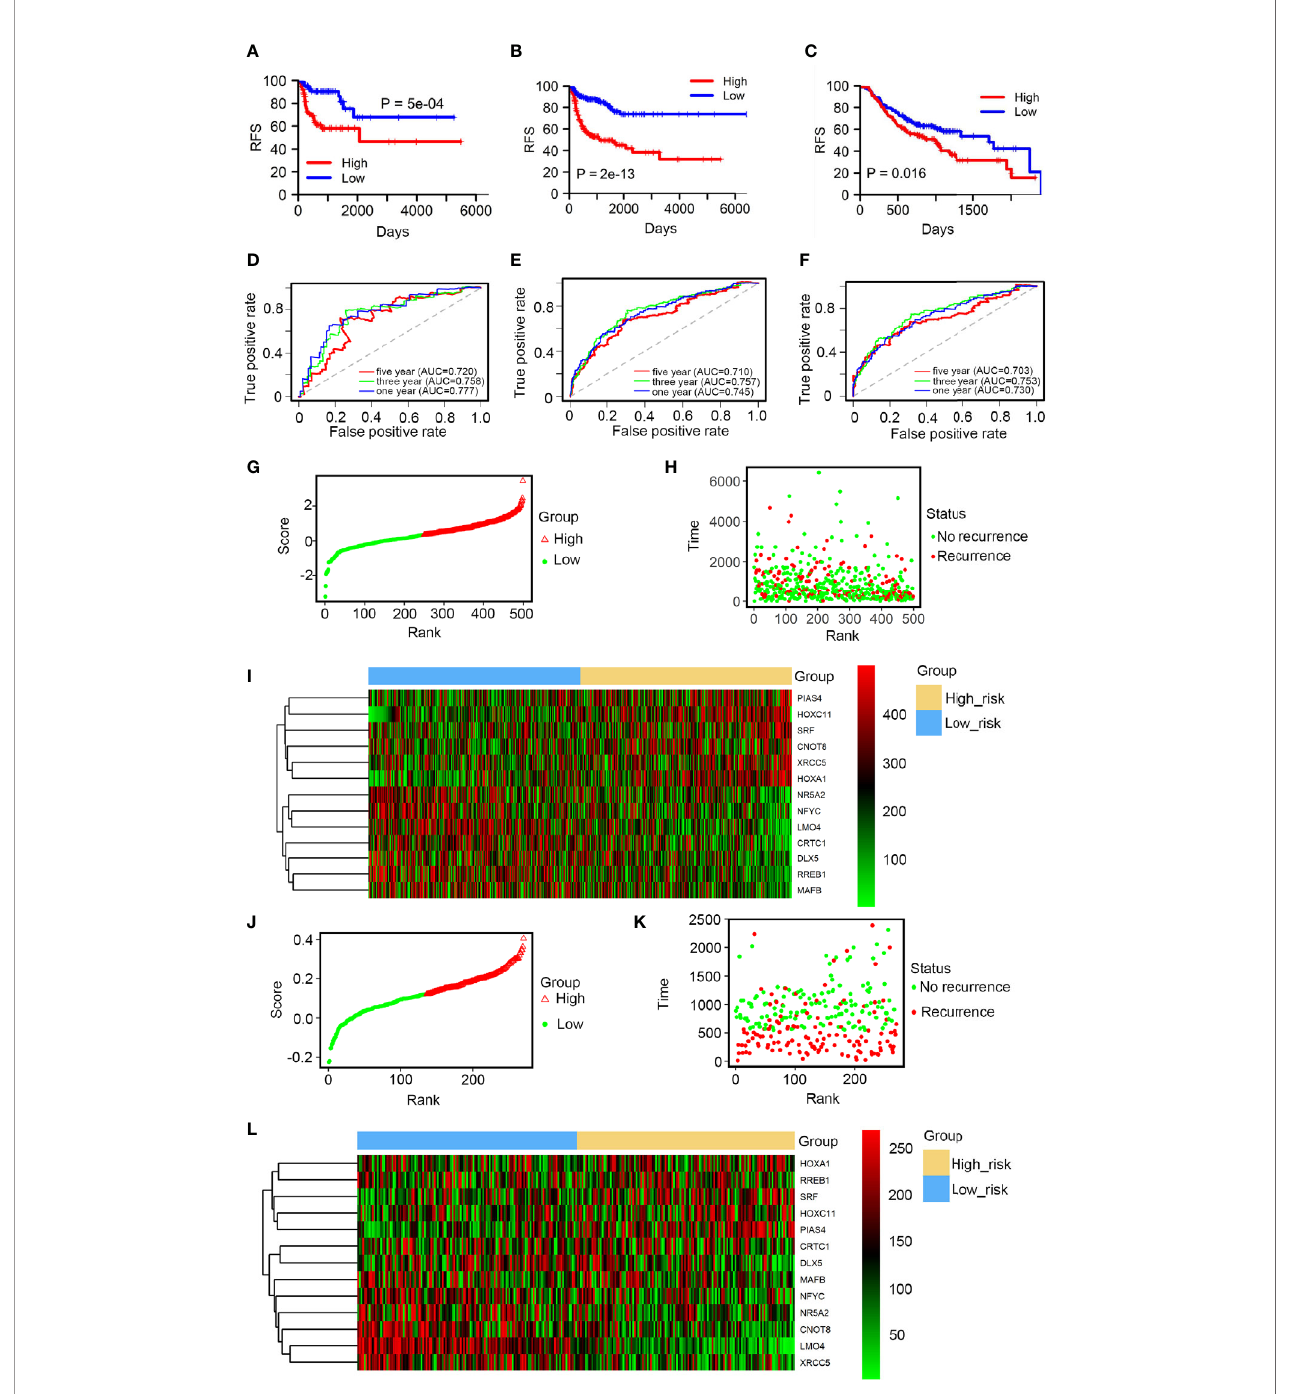
FIGURE 2 | Prognostic performance of the 12-TF signature in HNSCC. (A – C) Kaplan-Meier and ROC analysis of patients with HNSCC in entire TCGA set, the internal validation and external validation, respectively. (D – F) Kaplan-Meier analysis with two-sided log-rank test was conducted to evaluate the differences in RFS between the low-risk and high-risk cases. 1-, 3-, 5-year ROC curves of the 12-TF signature were applied to measure the value in predicting HNSCC patients ’ RFS in entire TCGA set, the internal validation and external validation, respectively. (G – I) TF risk score analysis of 499 HNSCC samples in TCGA database. TF risk score distribution against the rank of risk score (G) . Average risk score was set as the cut-off point. Recurrence free survival status of HNSCC patients (H) . Heatmap of 12 TFs expression pro fi les of HNSCC patients (I) . (J – L) TF risk score analysis of 270 HNSCC samples in the GEO dataset. TF risk score distribution against the rank of risk score (J) . Average risk score was set as the cut-off point. Recurrence free survival status of HNSCC patients (K) . Heatmap of 12 TFs expression pro fi les of HNSCC patients